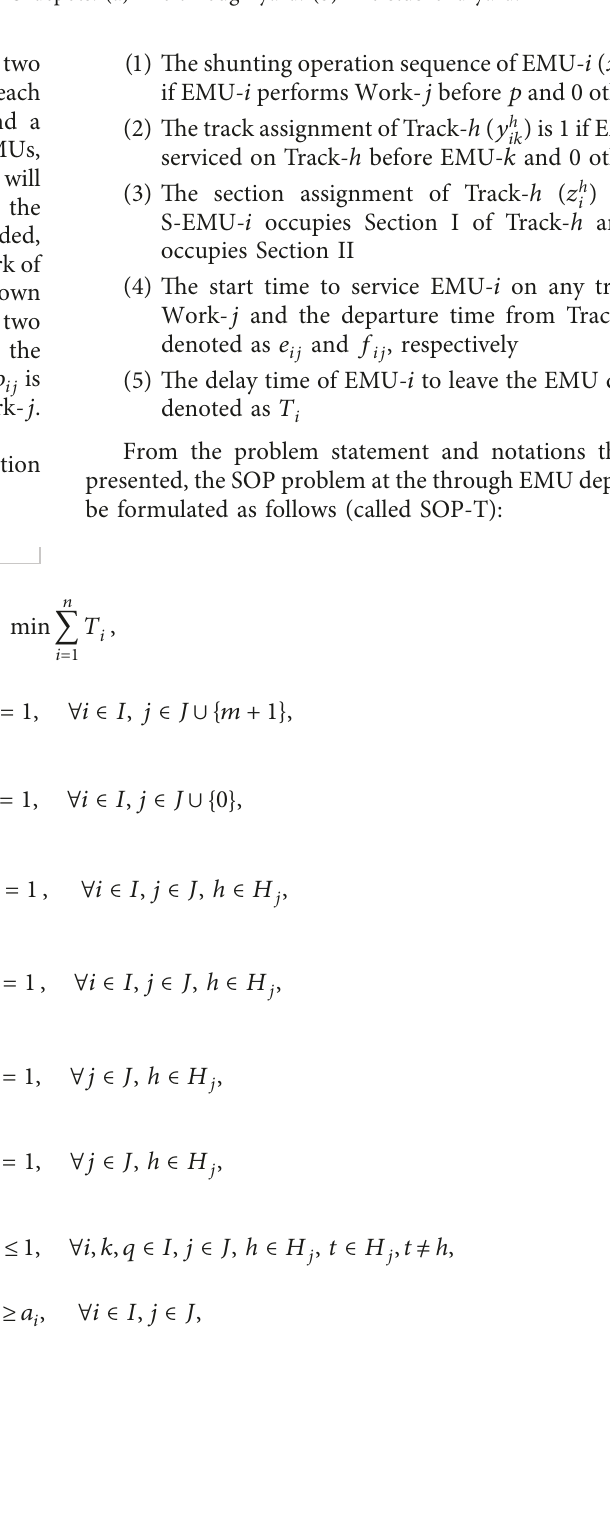
Figure 1: Two kinds of yard layouts at EMU depots. (a) The through yard. (b) The stub-end